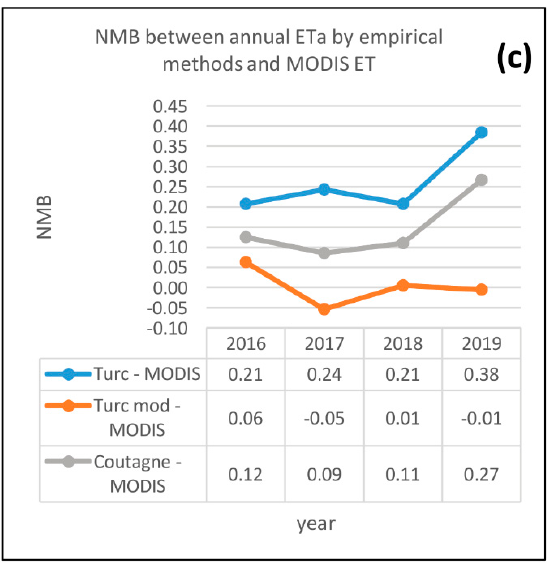
Figure 5 . Comparison between ( a ) RMSD, ( b ) MB, and ( c ) NMB of ETa by empirical methods and MODIS ET for 2016 – 2019 .